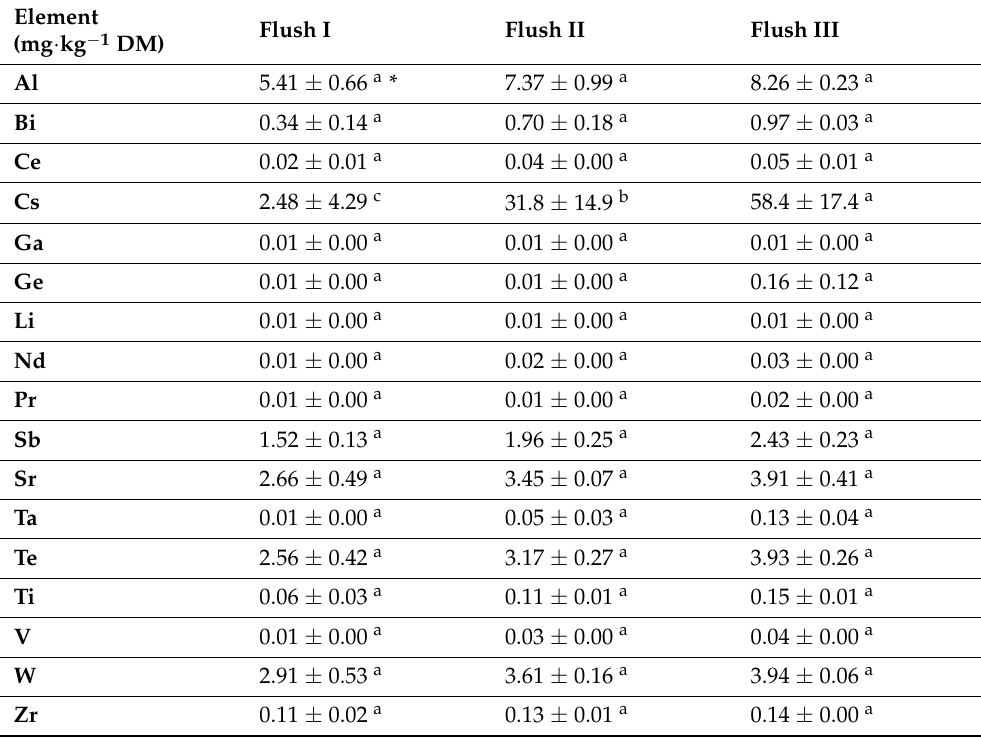
Table 6. Concentrations of NNEs in the fruiting bodies of P. djamor cultivated on